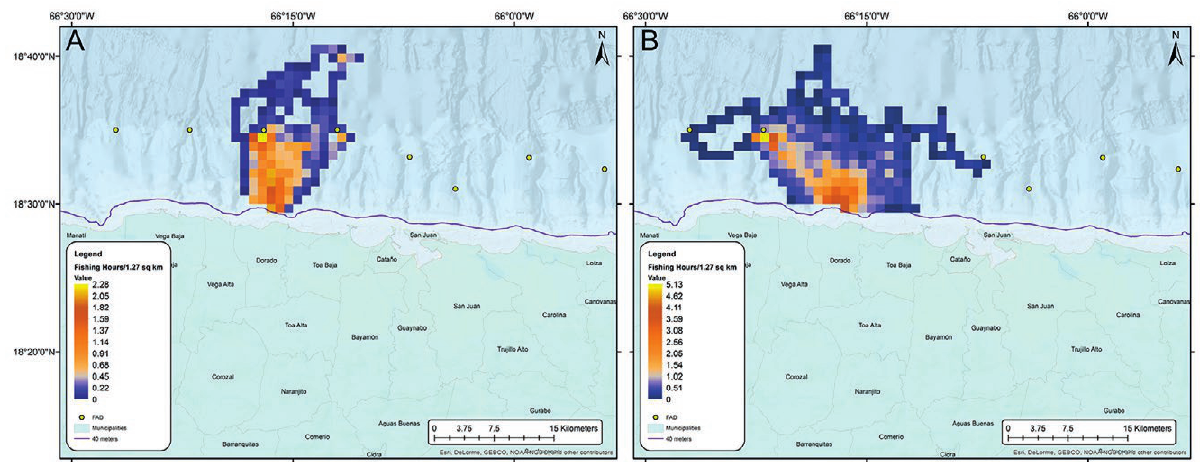
Fig. 6. – Fishing hours (A) before (10/25/2016-1/16/2017) and (B) after (1/17/2017-5/14/2017) the loss of two FADs nearest vessel A’s home port of Dorado, Puerto